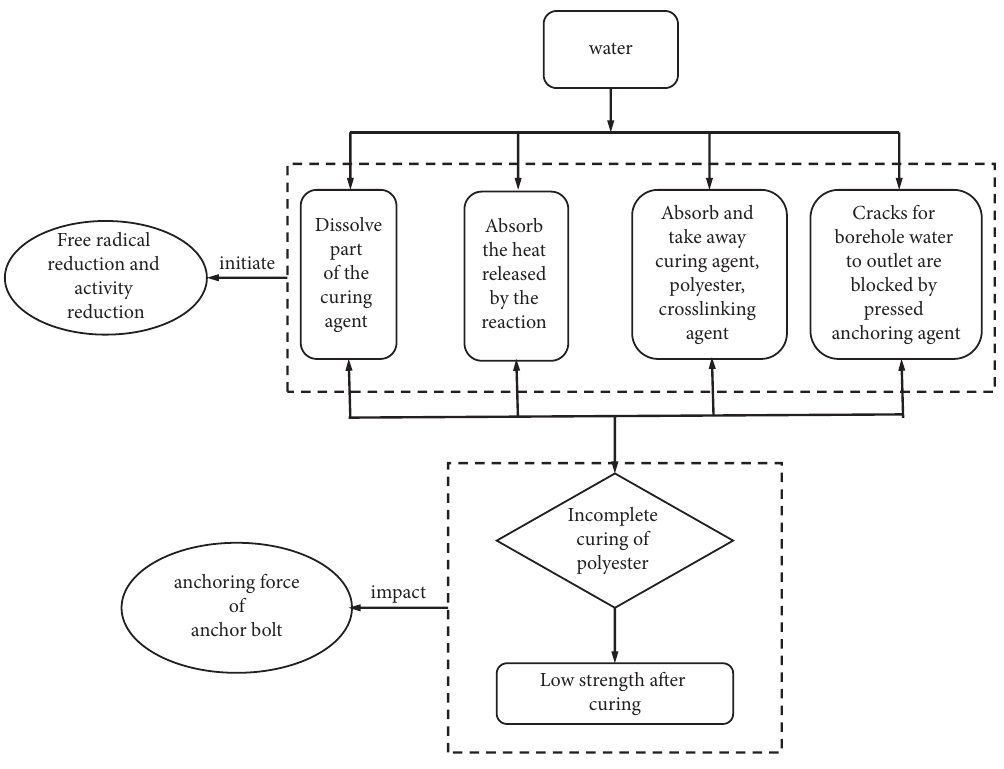
Figure 1: Mechanism of water effect on anchor